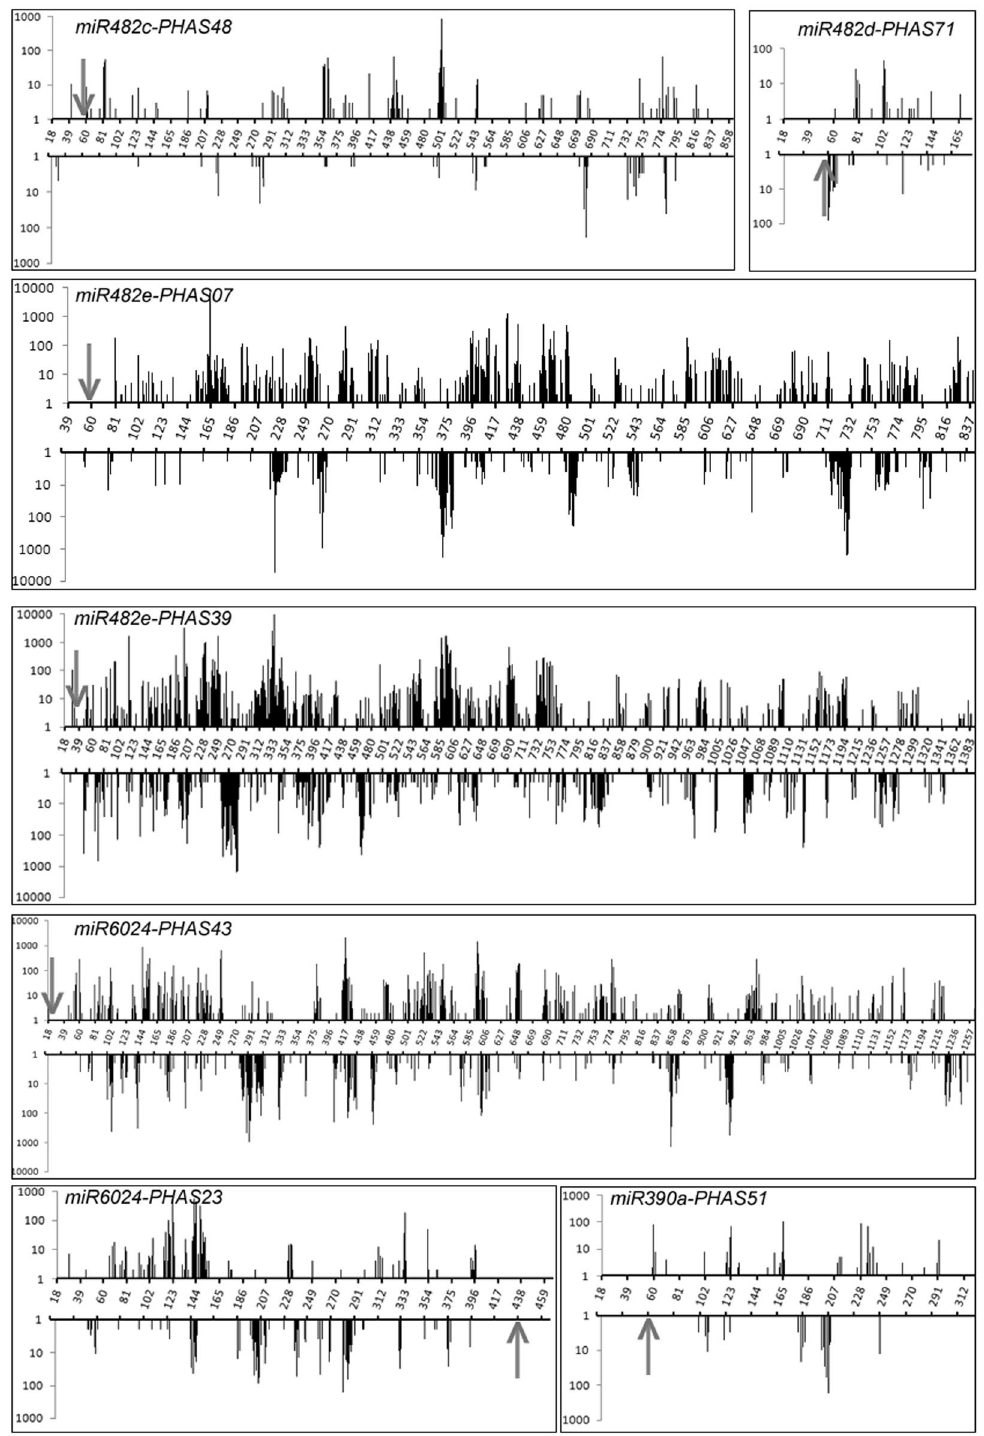
Figure 1. Read abundance distribution of seven PHAS loci in the sRNA library. The arrows indicate the miRNA cleavage sites. The X-axis represents a double-stranded PHAS locus. Abscissa indicates the phasiRNA position mapped within the PHAS locus. Ordinate indicates the read abundance of the mapped